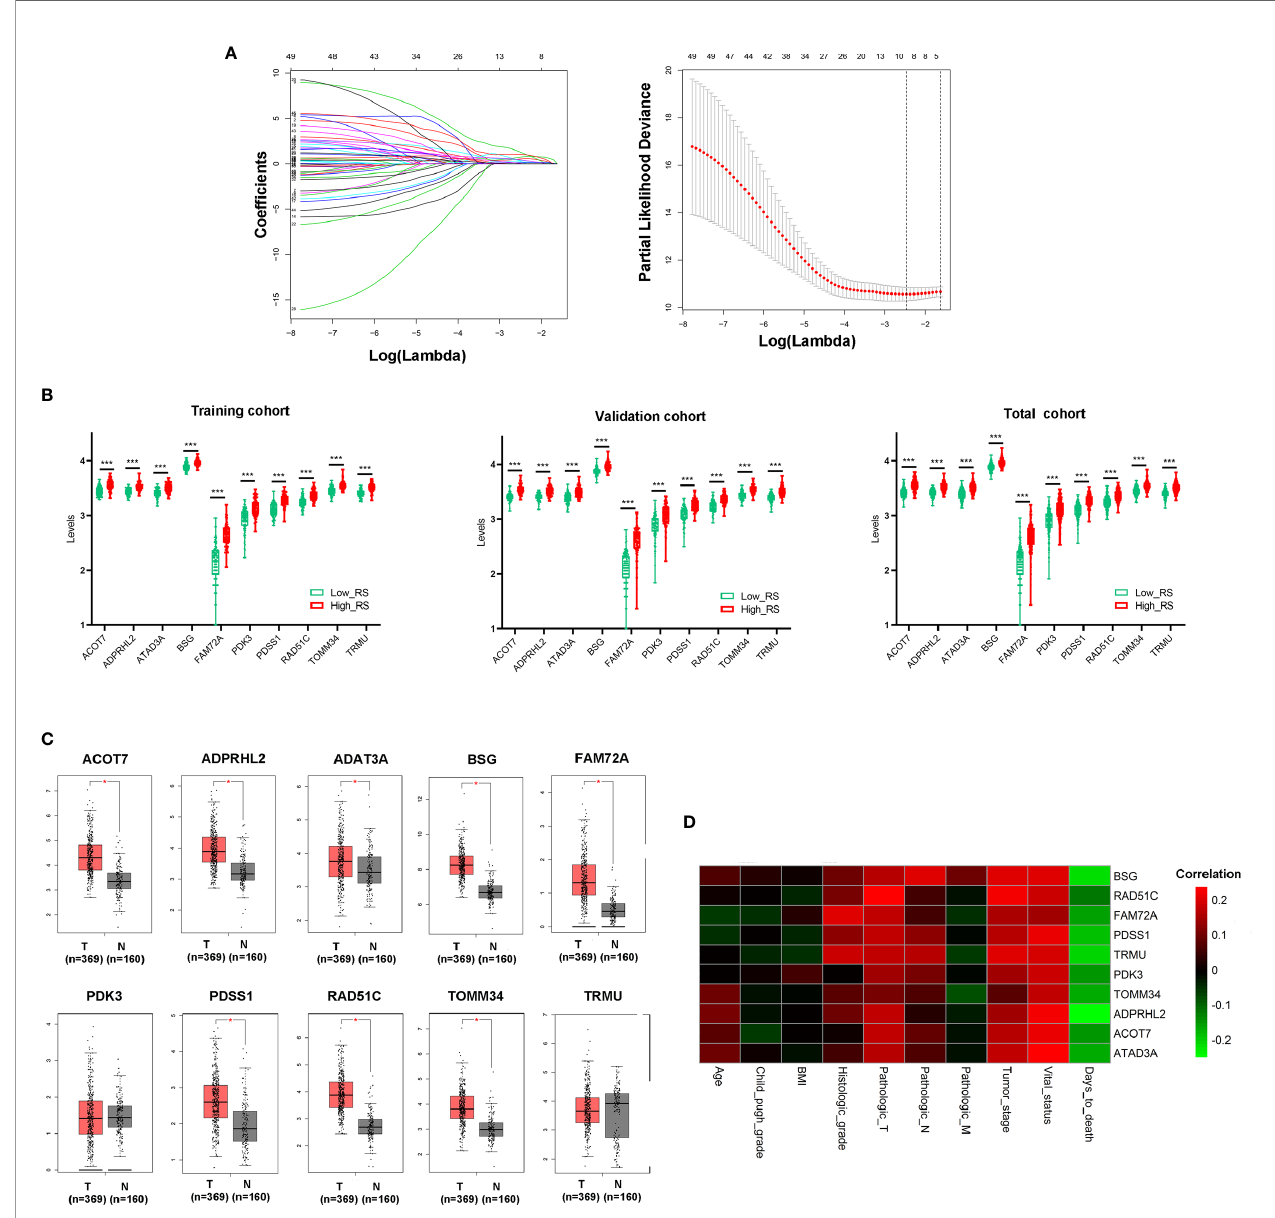
FIGURE 3 | Construction of Mito-RGs-based prognostic classi fi er. (A) Results of the LASSO Cox regression suggested that all 10 genes were essential for the classi fi er. (B) Expression levels of all 10 genes of the classi fi er in the high- and low-risk groups from the training, validation, and total cohorts. (C) Expression of the 10 genes in the classi fi er between HCC (T) and normal liver tissues (N) in GEPIA (http://gepia.cancer-pku.cn/) based on the TCGA and GTEx databases. * P < 0.05. (D) Correlation between the 10 genes in the classi fi er and the clinical features of HCC. RS, risk